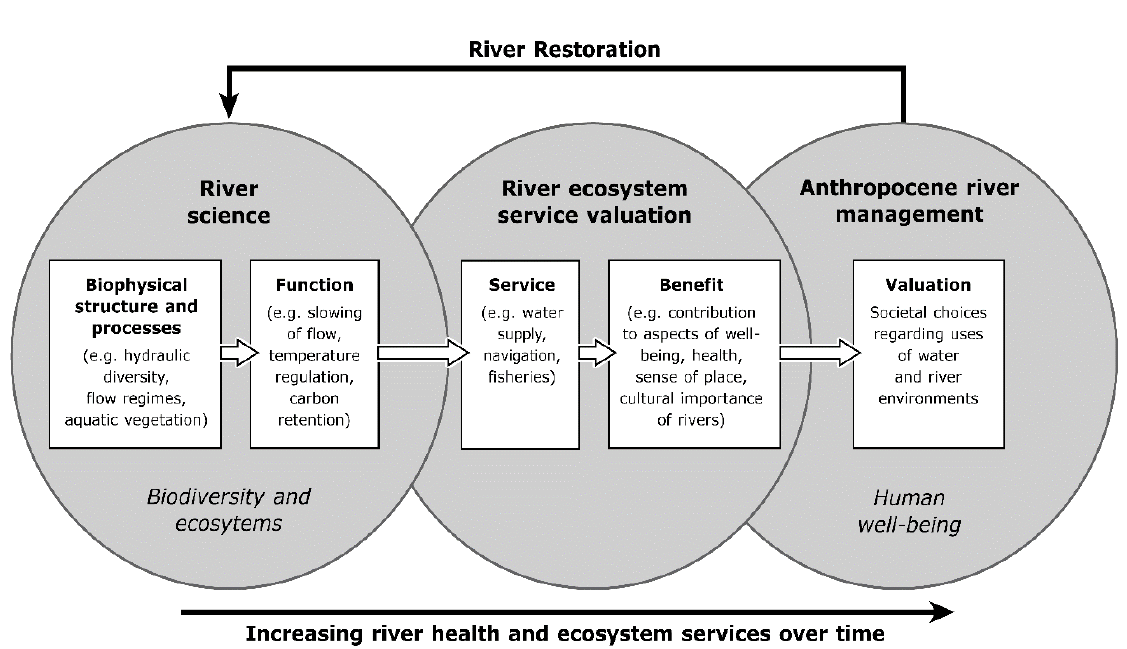
Figure 4. The links between societal choices and values in river management and restoration.